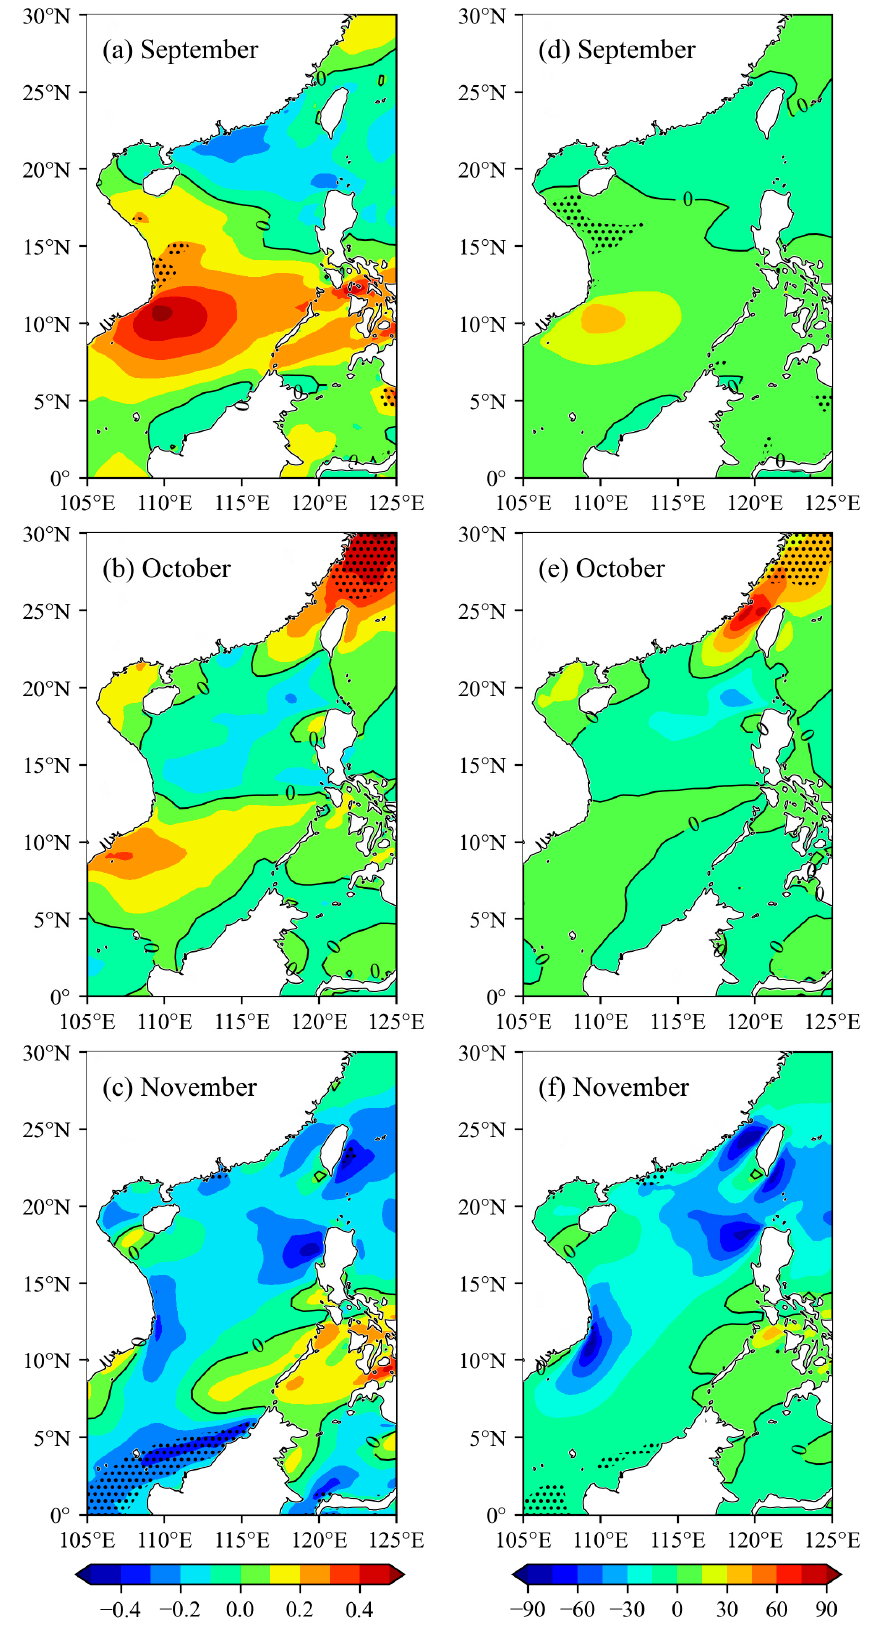
Figure 10. As in Figure 7, but for September ( a , d ), October ( b , e ) and November ( c , f ).